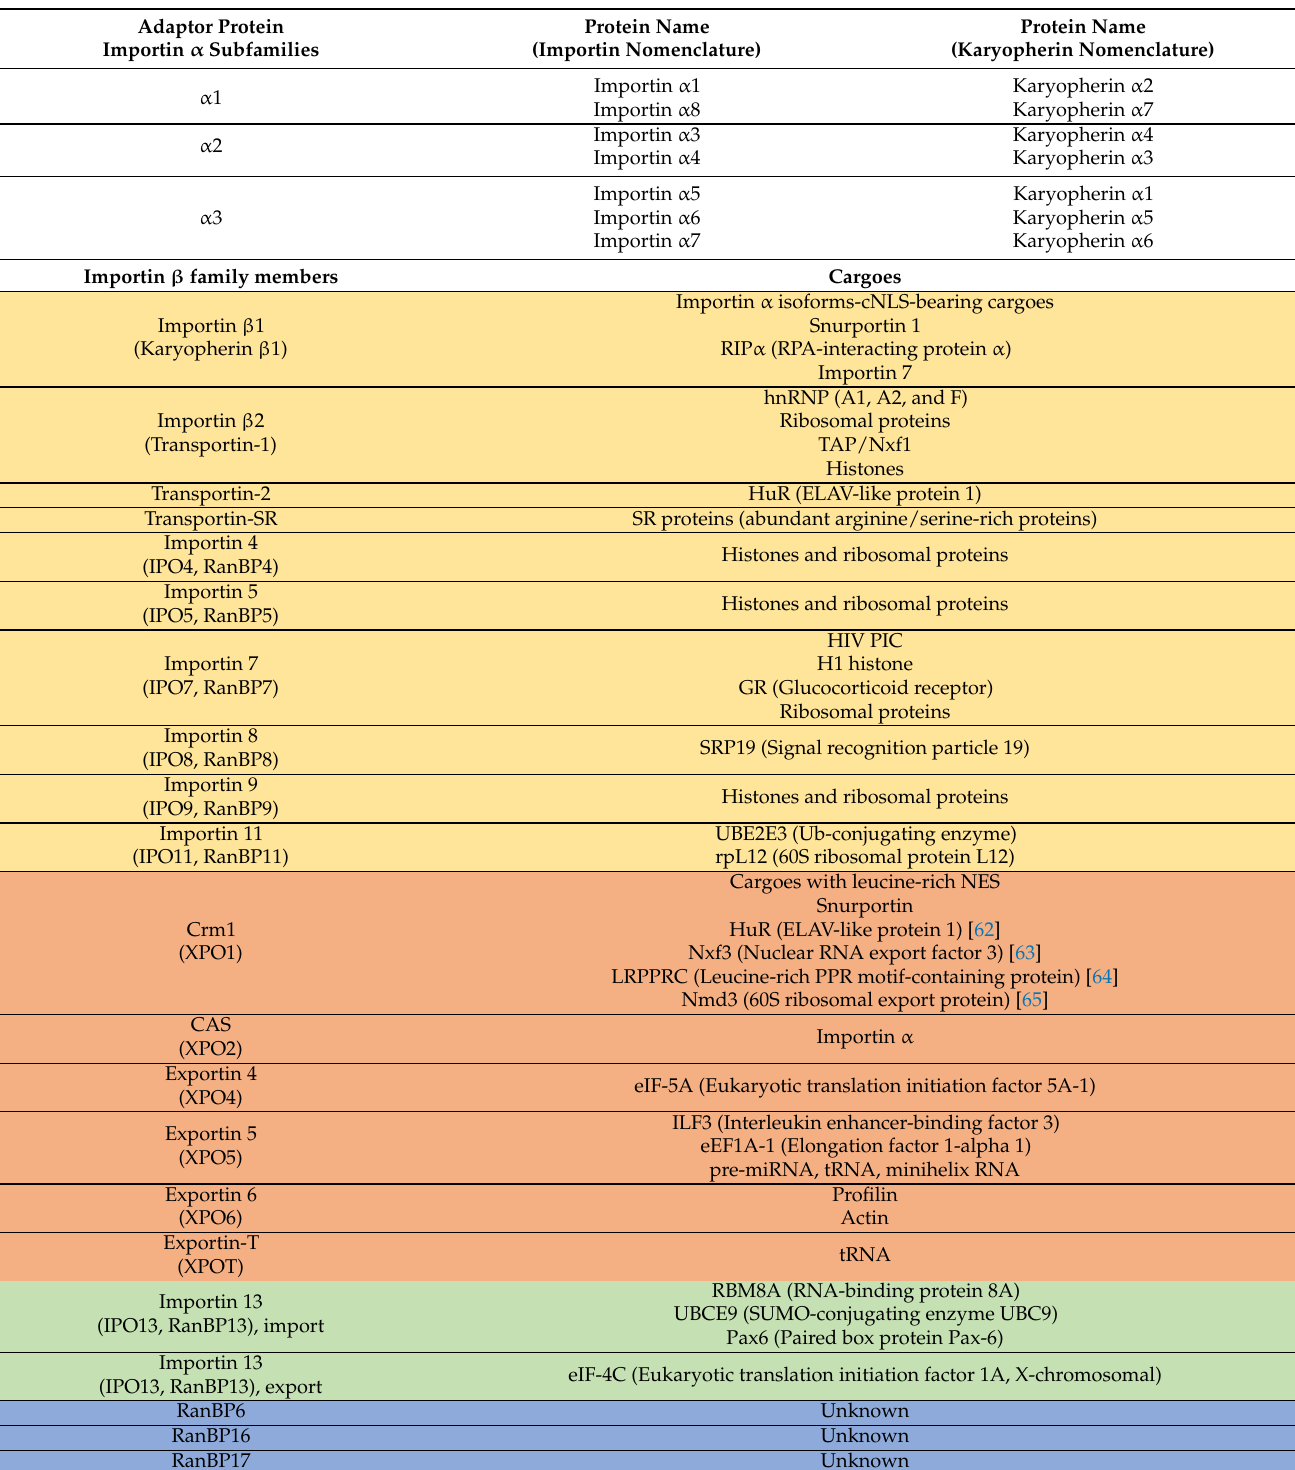
Table 1. List of the nuclear transport receptors (NTRs) involved in nucleocytoplasmic shuttling. Adaptor Protein Importin α